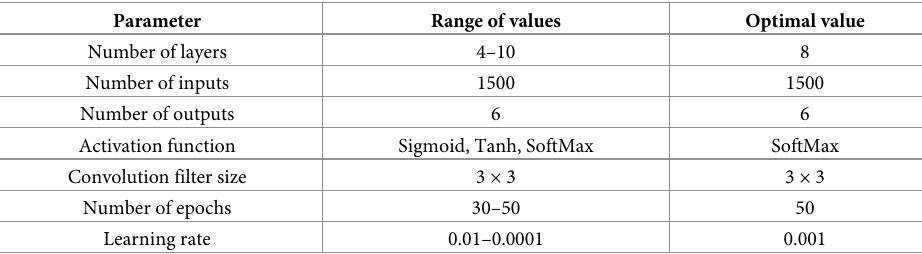
Table 2. Parameter used in DCNN for